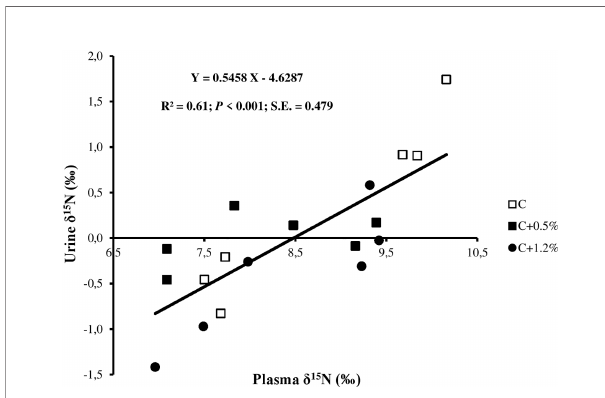
FIGURE 6 | Relationship between nitrogen (N) use ef fi ciency (NUE) and plasma N isotopic discrimination (plasma D 15 N) for individual observations of the sheep offered three different levels of non-protein N: C, control dietary treatment with maintenance N intake (NI) allowance; C+0.5%, control dietary treatment with maintenance plus an additional 15% NI allowance; C+1.2%, control dietary treatment with maintenance plus an additional 33% NI allowance. The error bars show SE.